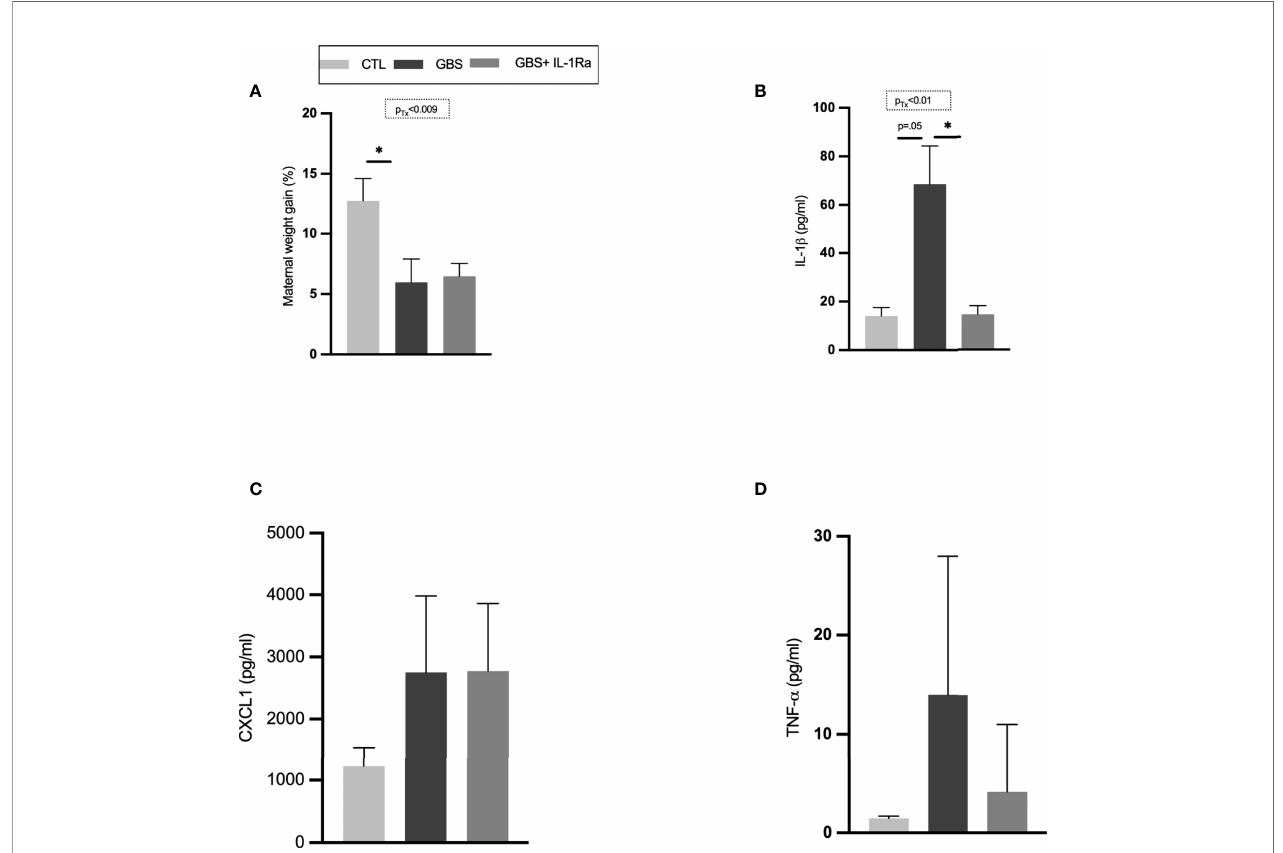
FIGURE 1 | Maternal IL-1Ra treatment increased gain weight and reduced IL-1 b released within the sera of GBS-infected dams. Comparison of mean maternal weight from G18 to G22 (A) . Mean maternal serum concentration of IL-1 b (B) , CXCL1 (C) and, TNF- a (D) quanti fi ed by ELISA between CTL, GBS, and GBS plus IL-1Ra-exposed dams at 72 h post-GBS infection. Data were collected from three individual experiments. Analyses were performed between the experimental groups using Kruskal-Wallis test with Dunn ’ s multiple comparisons; *p < 0.05. Bars show mean ± SEM. Number (n) of dams: CTL (n = 6), GBS (n = 9), and GBS plus IL-1Ra (n = 8); n of serum samples: CTL (n = 4-6), GBS (n = 6-9), and GBS plus IL-1Ra (n = 6-8). CTL, control; ELISA, enzyme-linked immunosorbent assay; CXCL1, chemokine (C-X-C motif) ligand 1; G, gestational day; GBS, group B Streptococcus; IL-1Ra, IL-1 receptor antagonist; SEM, standard error of the